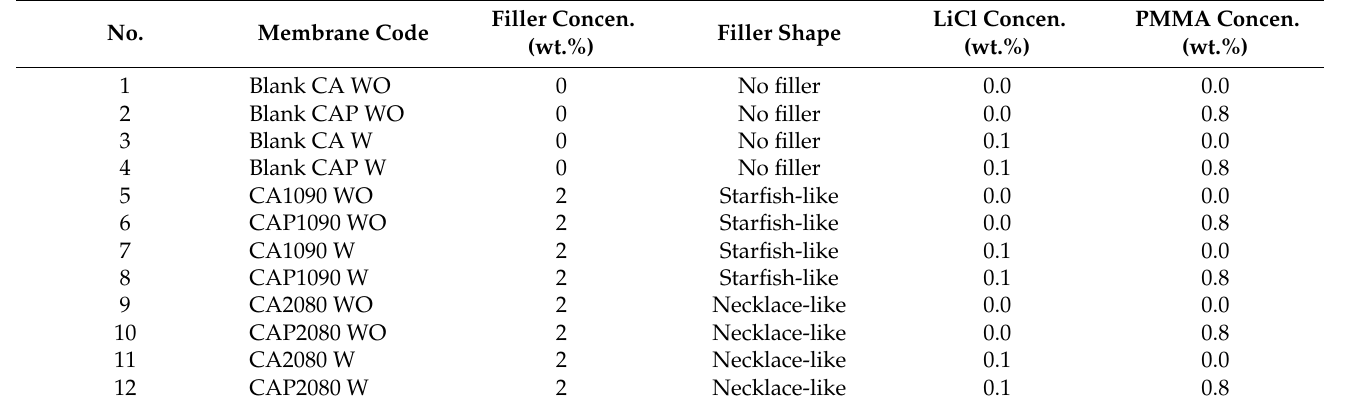
Table 1. Coded names and compositions of the fabricated magnetic mixed CA matrix